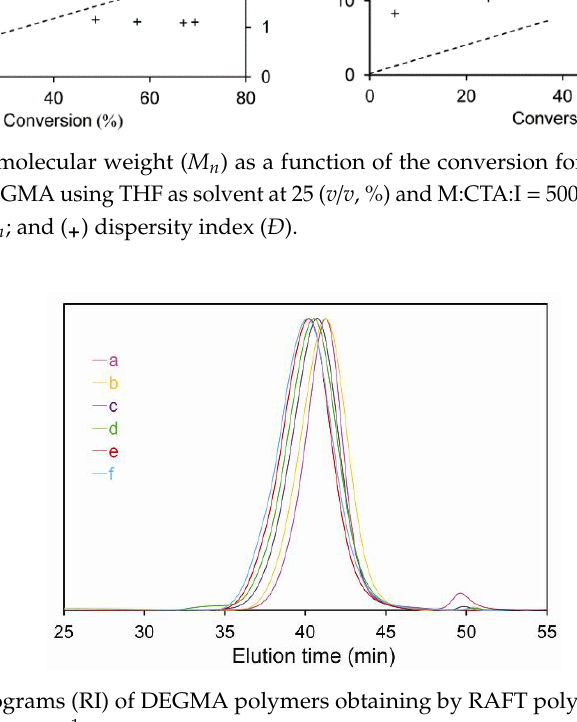
Figure 5. Chromatograms of the polymers and copolymers of DEGMA and OEGMA obtained by RAFT polymerization. The composition and purity of the respective polymers were determined by hydrogen nuclear magnetic resonance ( 1 H-NMR). Figure 6 shows the 1 H-NMR spectrum of POEGMA, PDEGMA, and